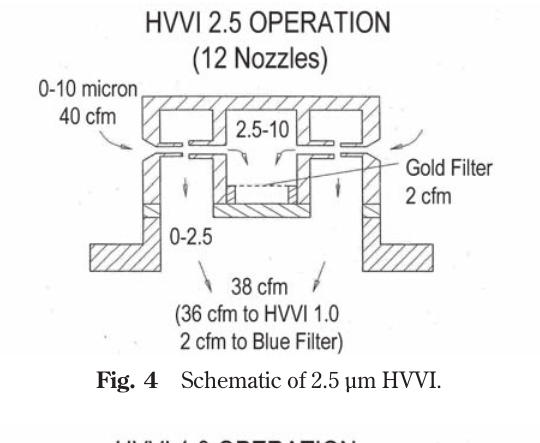
Trichotomous Sampler. 1.0/2.5/10